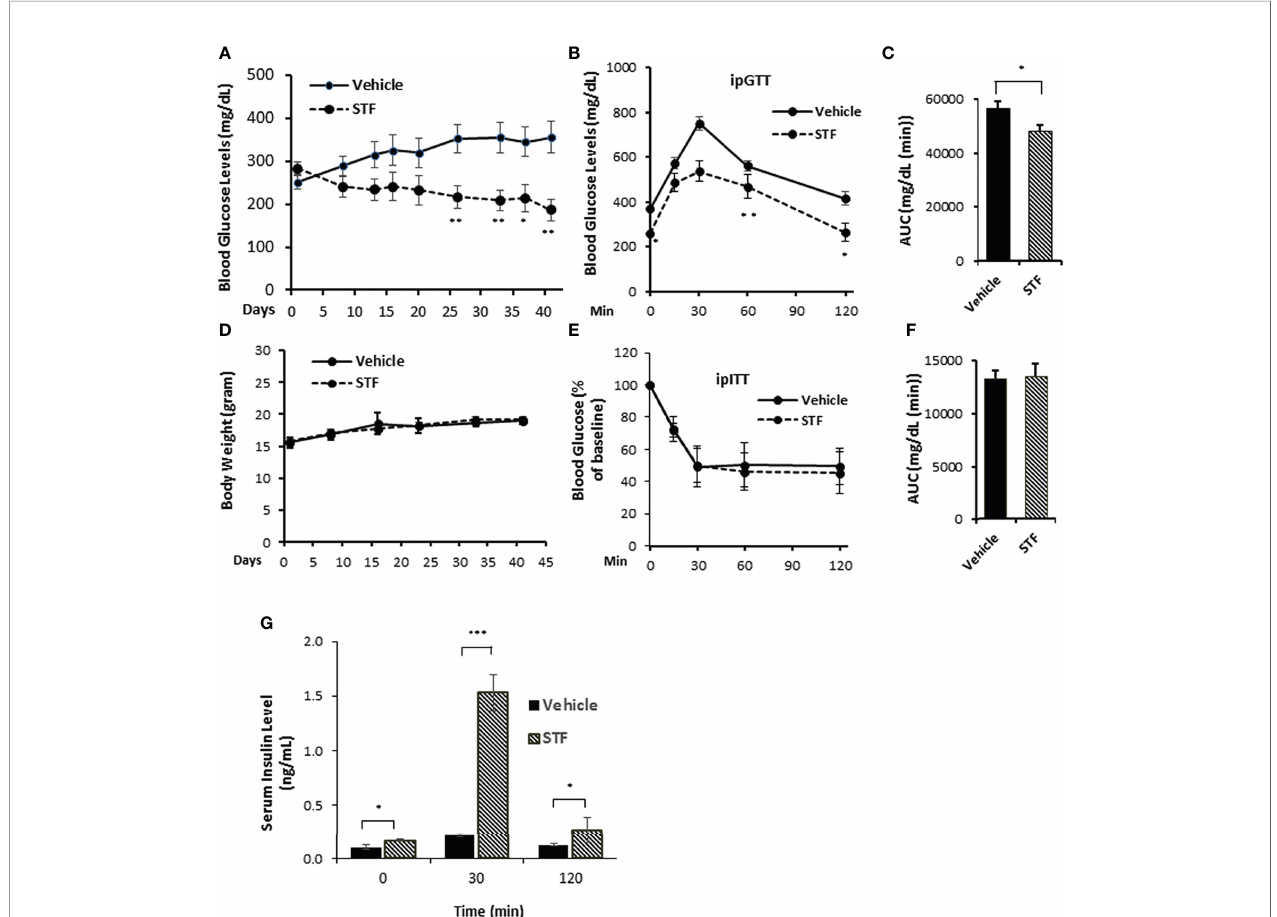
FIGURE 2 | STF ameliorates diabetic conditions of Akita mice. (A) Fasting blood glucose levels were measured in Akita mice treated with vehicle (n = 8) or STF (n = 7) at indicated time points. (B, C) Glucose tolerance test. Blood glucose levels (B) measured at indicated time points after intraperitoneal injection of glucose (1.5g/kg body weight) following 6-h fasting and the AUC (area under the curve, C ) at the end of 5-week treatment. (D) Body weight of mice. (E, F) Insulin tolerance test. Blood glucose levels (E) measured at indicated time points after intraperitoneal injection of insulin (0.75 IU/kg body weight) following 4-h fasting and the AUC a day before euthanization (F) . (G) In vivo glucose-stimulated insulin secretion. Serum insulin levels measured at indicated time points after intraperitoneal injection of glucose (1.5g/kg body weight) following 6-h fasting as in (C) *P < 0.05, **P < 0.01, and ***P < 0.001. Bars indicate